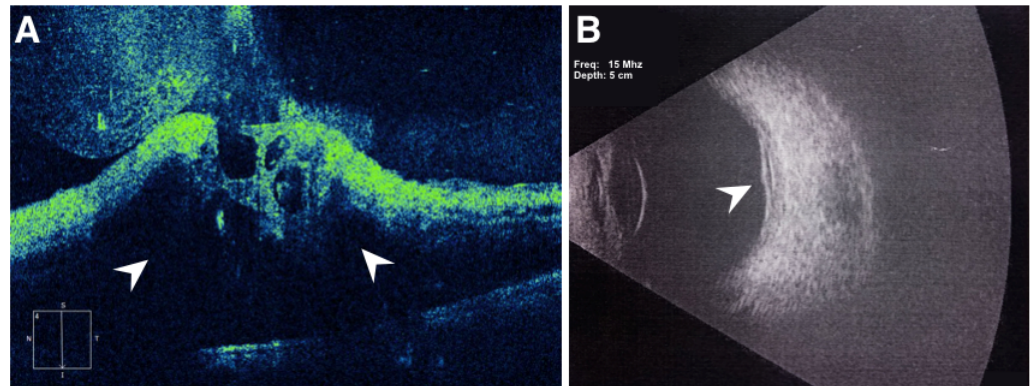
Figure 2: The optical coherence tomography image shows extensive macular edema seen as hyporeflective regions within the retina (arrowhead, 2A). Back shadowing due to superficial hemorrhages is also seen. Ultrasound imaging shows thickening of the retina over the posterior pole (arrowhead, 2B) .